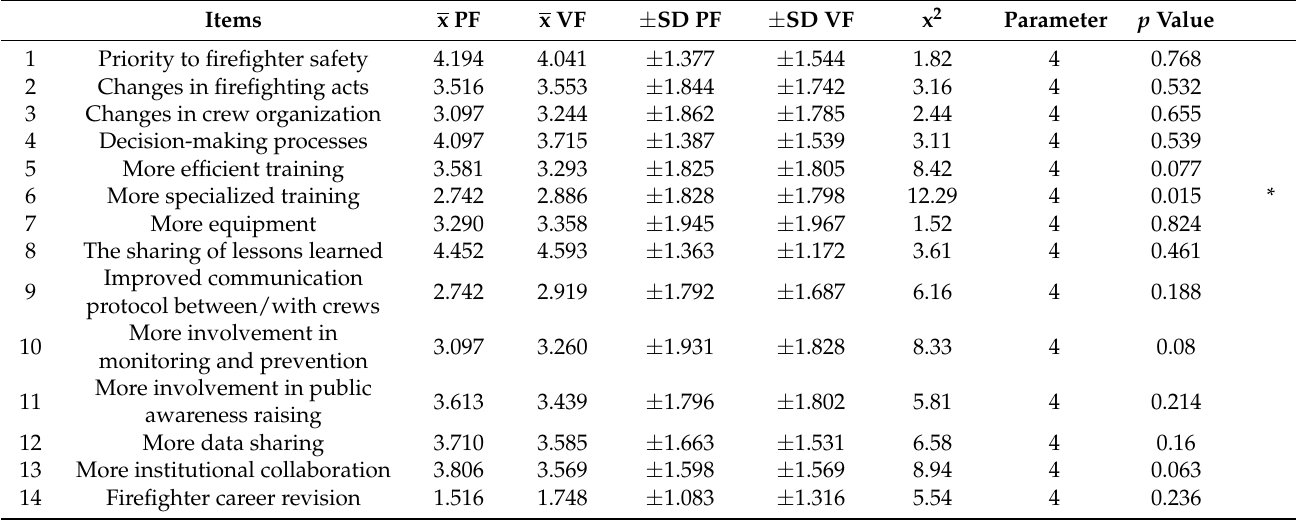
Table 11. Lessons learned (consequences), PF vs. VF ( n =